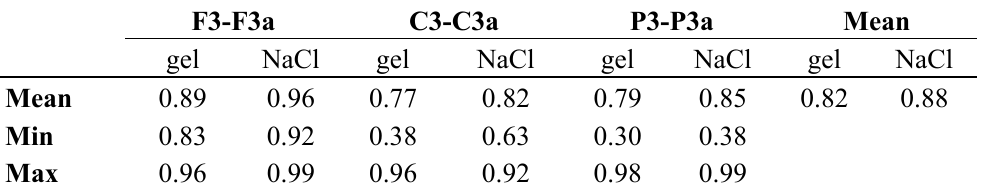
Table 2. Correlation in the time domain between the three pairs of textile electrode Type I and standard electrodes using gel and NaCl, respectively (standard electrodes are denoted with an “a” after the channel name). To the right the grand average is given.